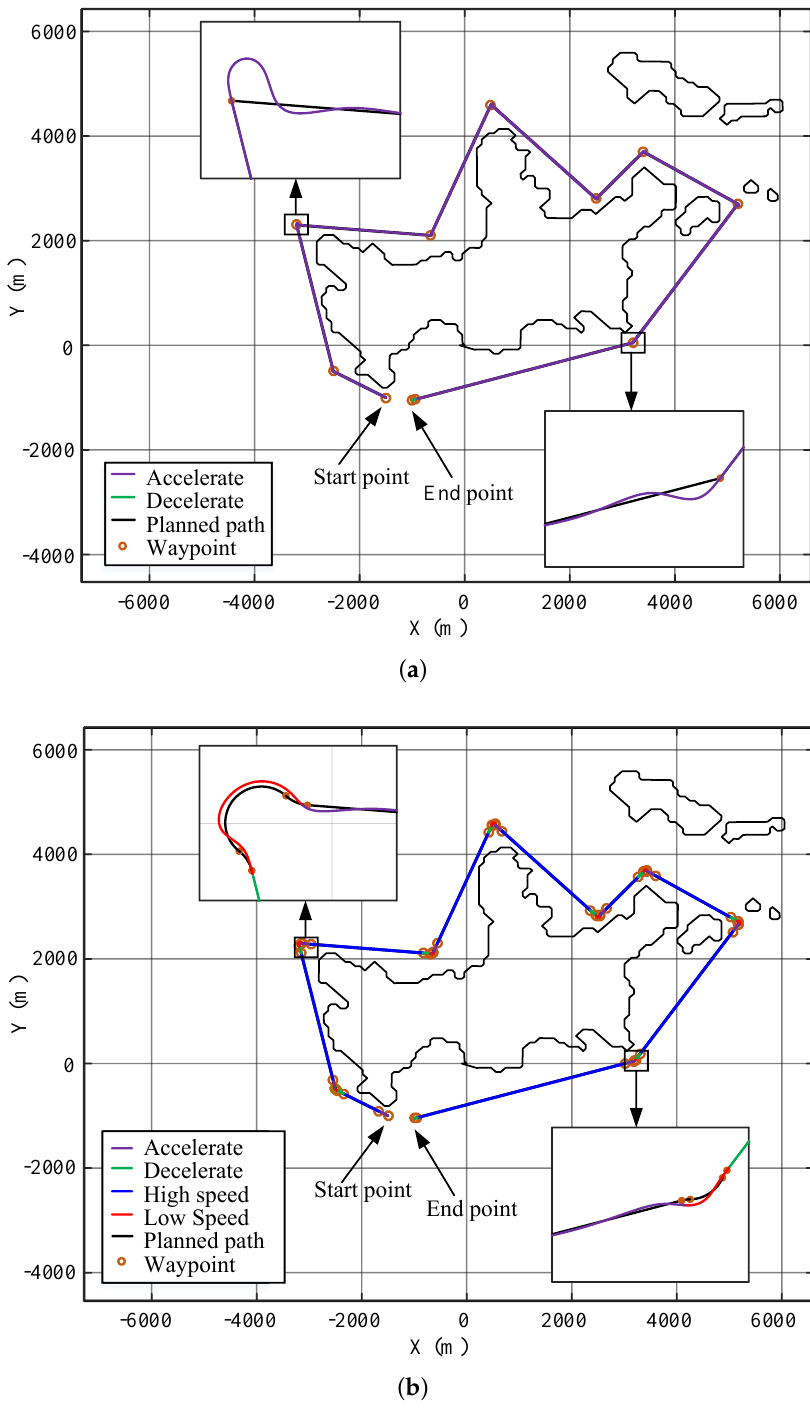
Figure 17. Simulation of water sampling: ( a ) Original path-tracing results. ( b ) Optimized path-tracing